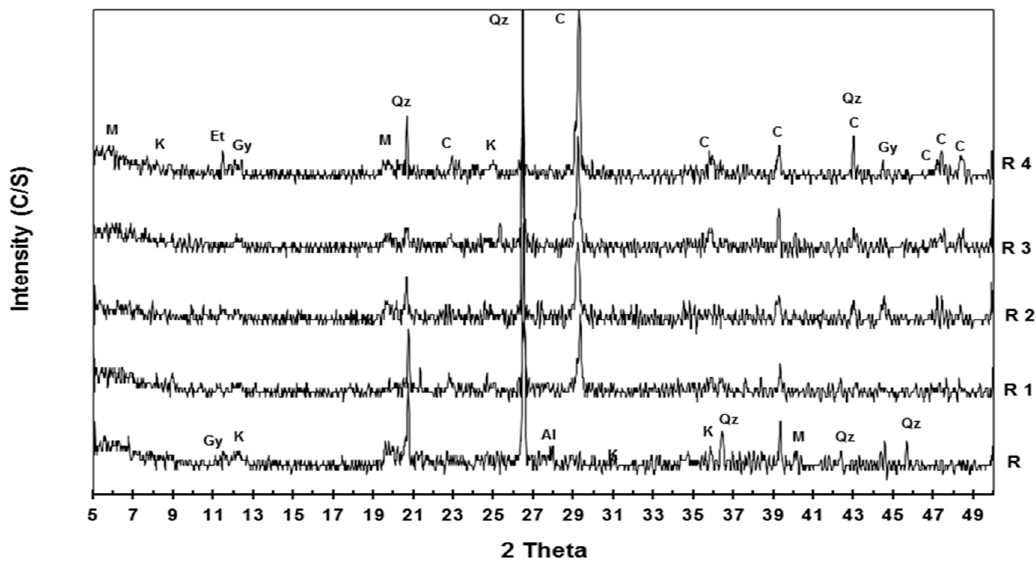
Figure 5. XRD patterns of the specimens of different mixes that had been cured for four weeks.